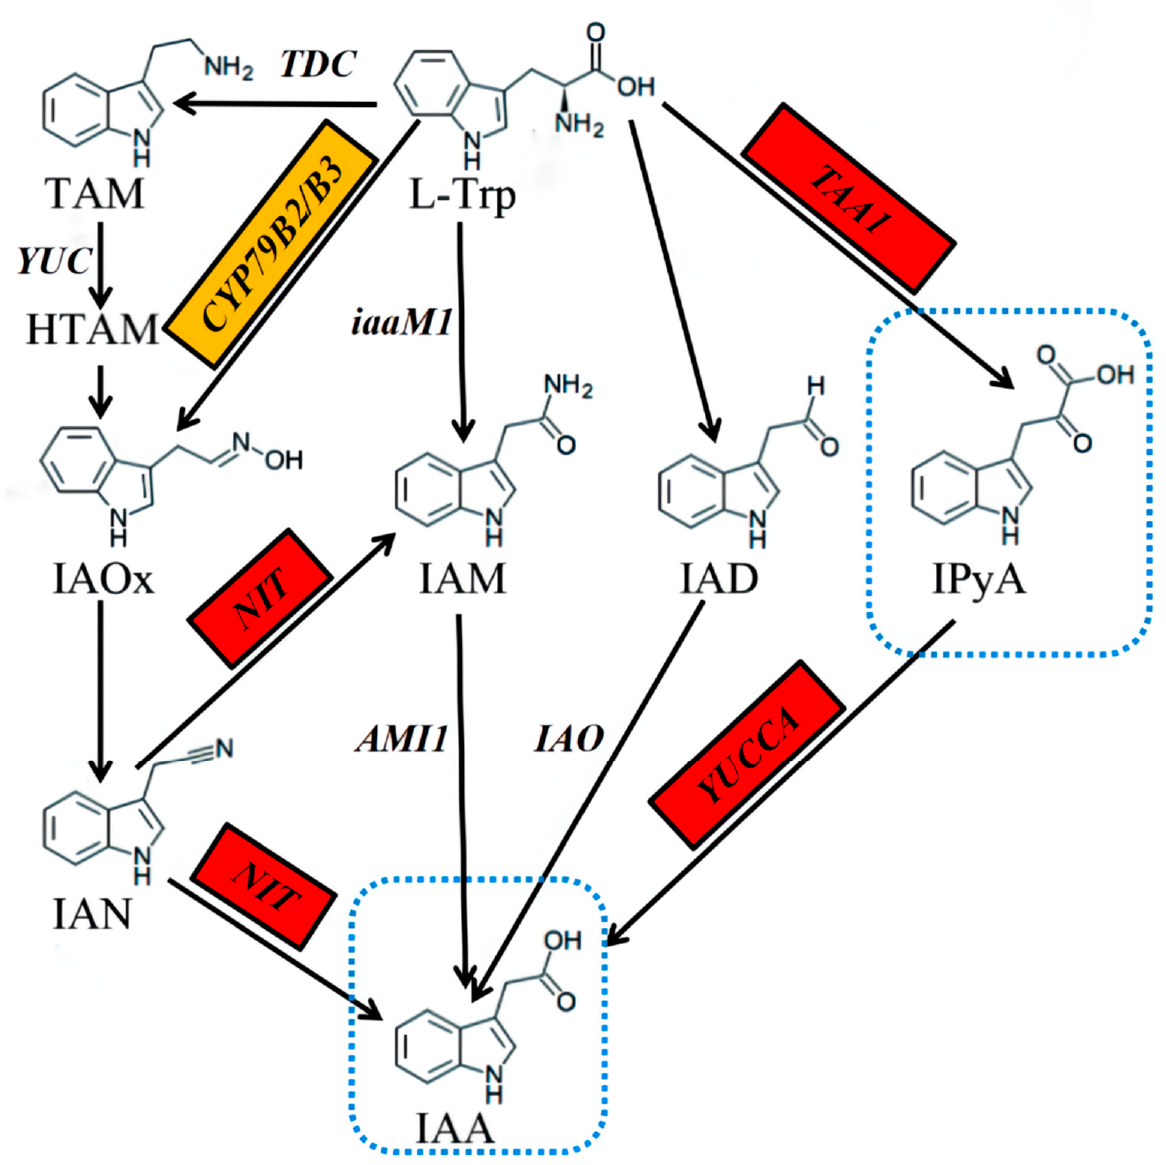
Figure 5. The changes of genes and metabolites in IAA biosynthesis pathway. Note: The red box indicates that the gene is down-regulated at both the transcription and protein levels; the yellow box indicates that the gene has no difference in the transcription level, but the expression is down- regulated at the protein level; the blue dashed box indicates that the differential metabolites are down-regulated.